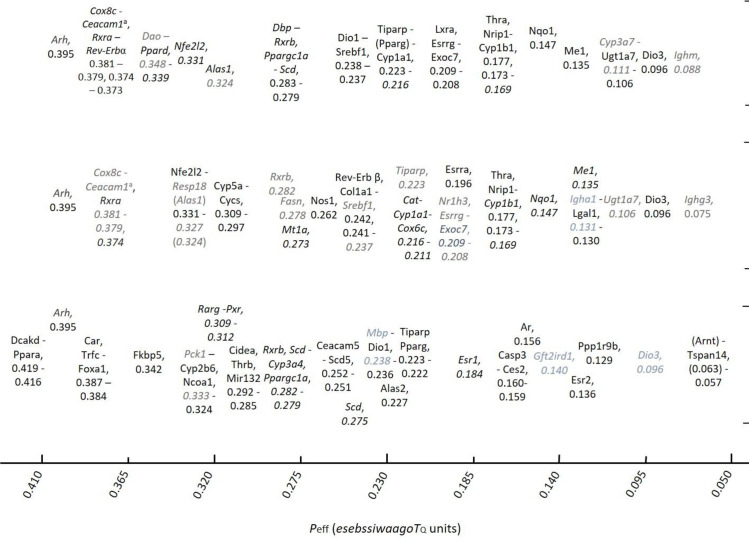
Alterations in cell micro-compliance due to sub-acute exposure to polychlorinated biphenyl high affinity metabolites with specificity for intracellular or extracellular deiodinases.Lower limit of the lower tier Peff for transcriptional activation is increased to 0.106 (Ugt1a7) during a Cmicro contraction response with a decrease in Peff
Cmicro to < 0.106 > 0.088 (Ighm) esebssiwaagoTQ units during the expansion response; and the lower limit of the upper tier Peff is increased to between ~0.395 (AhR) to 0.381 (Cox8c) - 0.379 (Ceacam1a) with an interval increase in Peff
Cmicro in juxtaposition to ≤ 0.416 (Pparα) ≥ 0.395 (AhR) esebssiwaagoTQ units. The upper tier apparent interval Peff
Cmicro contraction response is between a Peff of 0.348 (Dao1) - 0.331 (Nfe2l2) and 0.379 esebssiwaagoTQ units. The Cmicro contraction-expansion response range is 0.225–0.275 (min BoR; Cox8c, Nfe2l2; Ugt1a7) to 0.243–0.293 (max BoR; Cox8c, Nfe2l2; Ighm) [p-dioxin (TCDD), upper bracket, no. 1]. In the AhR-Erβ (Arnt), Pparδ, Errγ (LxRα): Dio3/Dio2 (Trα) pathway, the minimum expansion response phase of the positive Peff contraction-expansion is a result of transient Errα decrease in activation-mediated de-repression of Dio2. Lower limit of the lower tier Peff for transcriptional activation is increased to 0.130 (Lgal1) during a Cmicro contraction response with a decrease in Peff
Cmicro to < 0.088 ≥ 0.080 (Tgif1) -0.075 (Ighg3) esebssiwaagoTQ units during the expansion response; and the lower limit of the upper tier Peff is increased to between > 0.395 (AhR) and 0.387–0.381 (Cox8c) with an interval increase in Peff
Cmicro in juxtaposition to < 0.416 (Pparα) > 0.395 (AhR) esebssiwaagoTQ units. The upper tier apparent interval Peff
Cmicro contraction response is between a Peff of > 0.327 (Resp18) - 0.331 (Nfe2l2) and 0.381 esebssiwaagoTQ units. The Cmicro contraction-expansion response range is 0.201–0.251 (min BoR; Nfe2l2, Cox8c - Lgal1) to 0.2585–0.3085 [max BoR; Cox8c, Nfe2l2; Ighm, Tspan12 (avg)]. The range of delta (Δ) micro-compliance (Δ Cmicro) for the bracket no. 2 (co-planar PCB-126) and no. 1 (TCDD, std) comparison is between 0.024 (0.89) [Δ, ratio contraction] and 0.0155 (1.05) [Δ, ratio expansion; a.u.]. In the AhR-Erα (Arnt): Nrf-2:: Rev-Erbβ, (+,-) Errα: Dio3/Dio2 (Trα) pathway, the expansion response phase of the positive Peff contraction-expansion is a result of Trα-mediated overactivation of Dio3. Lower limit of the lower tier Peff for transcriptional activation is increased to 0.159 (Ces2) during a Cmicro contraction response with a decrease in Peff
Cmicro to between < 0.080 ≥ 0.063–0.057 (Tspan14) esebssiwaagoTQ units during the expansion response, and the lower limit of the upper tier Peff is increased to between 0.387 (Nr1h3, CAR; Trfc) and 0.384 (FoxA1) with an interval increase in Peff
Cmicro in juxtaposition to between 0.427 (Hnf4a) and 0.418 (Pparα)– 0.416 (Dcakd) esebssiwaagoTQ units. The upper tier apparent interval Peff
Cmicro contraction response is between a Peff of 0.324 (Cyp2b6, Ncoa1) and 0.312 (Nr1I2) esebssiwaagoTQ units. The Cmicro contraction-expansion response range is 0.165 [min BoR; Cyp2b6, Ces2] to 0.346 [max BoR; Dcakd, Nr1h3 (avg); Tspan12]. The range of delta (Δ) micro-compliance (Cmicro) for the bracket no. 3 (ie PCB-95, -153) and no. 1 (TCDD, std) comparison is between 0.060 (0.73) [Δ, ratio contraction] and 0.053 (1.18) [Δ, ratio expansion; a.u.]. In the Car (Pxr), Rarγ: Pparα/γ, Rxrβ (Srebf1 -Lxrβ): Arnt (AhR-Er)/Ar:: Dio1/Dio2 (Trβ) pathway, in which the expansion response phase of the positive Peff contraction-expansion is a result of Trβ-mediated overactivation of Dio1 and transcriptional repression of Dio2 at Peff (esebssiwaagoTQ units). plain text, increase in duration at Peff in reference to baseline; text in italics, increase in duration at Peff in reference to p-dioxin; and grey text in italics, decrease in duration at Peff in reference to baseline Legend text: maximum bounds of range (max BoR); minimum bounds of range (min BoR).